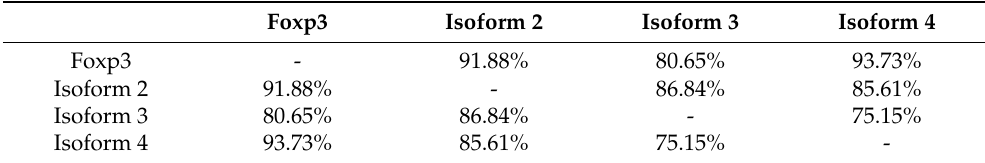
Table 2. The degree of identity of the amino acid sequence of the Foxp3 protein and its